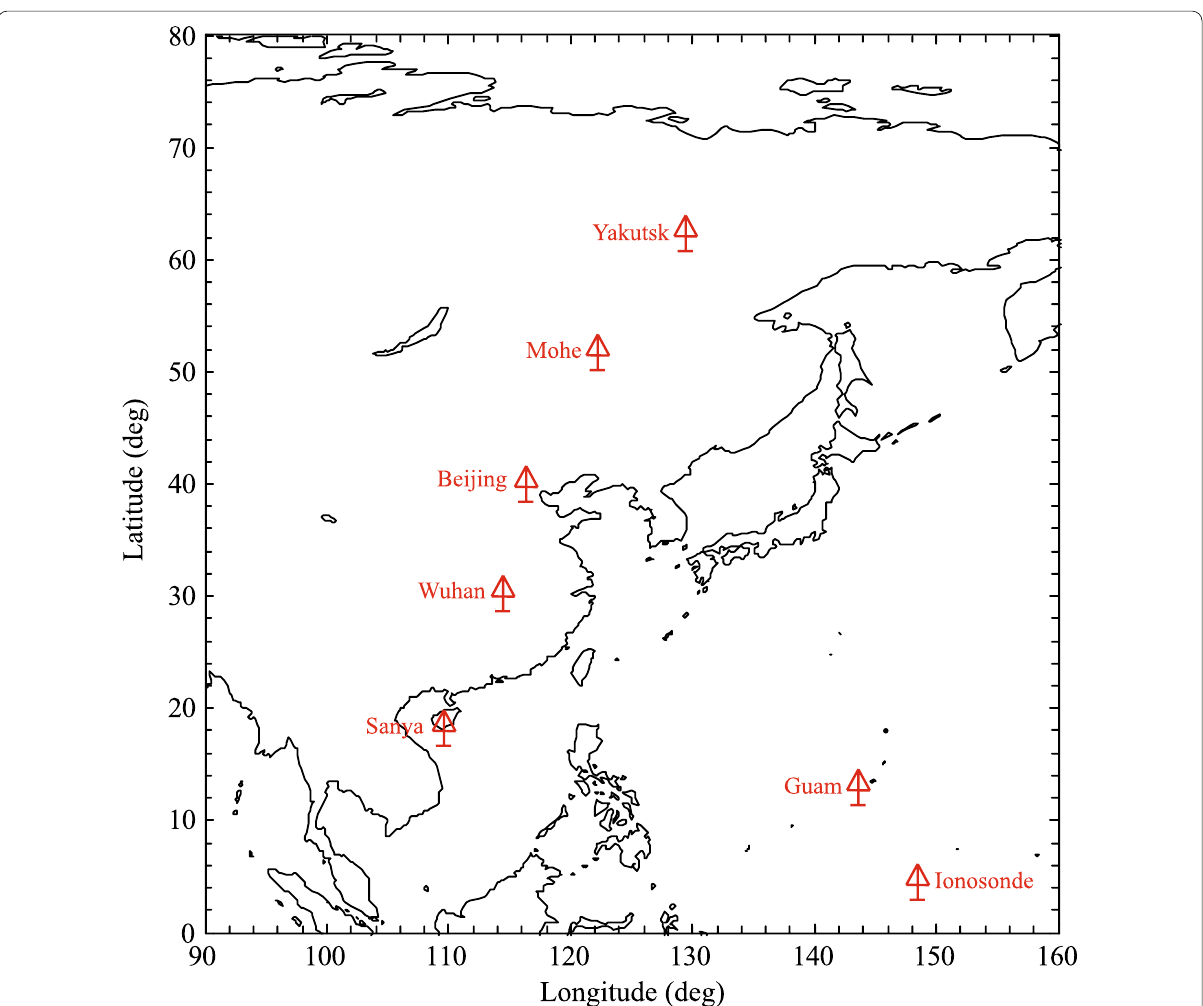
Fig. 1 Geographic locations of ionosondes at Guam, Sanya, Wuhan, Beijing, Mohe, and